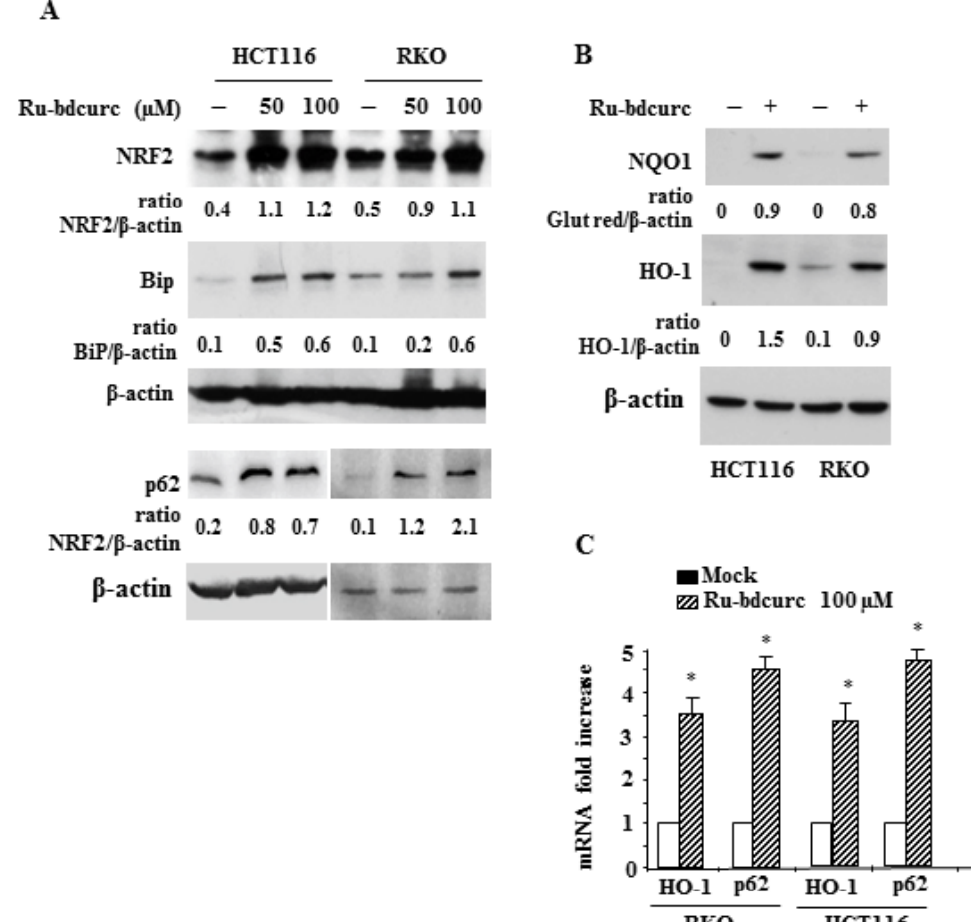
Figure 3. Activation of NRF2 and BiP pathways in response to Ru-bdcurc treatment. ( A ) Western blot analysis of the indicated proteins in RKO and HCT116 colon cancer cells treated with 50 and 100 µ M Ru-bdcurc for 48 h or ( B ) with 100 µ M Ru-bdcurc for 48 h. β -actin was used as protein loading control. The ratio of the proteins level vs. β -actin, following densitometric analysis, is reported. ( B ) Total mRNA was extracted from cells treated as in (A) to evaluate HO-1 and p62 gene expression by RT-PCR of reverse transcribed cDNA. Histograms represent the mean of three independent experiments ± S.D. ( C ) Western blot analysis of p62 in RKO and HCT116 cells treated as in ( A ) with 50 and 100 µ M Ru-bdcurc for 48 h. The ratio of the proteins level vs. β -actin, following densitometric analysis, is reported. * p ≤ 0.05.